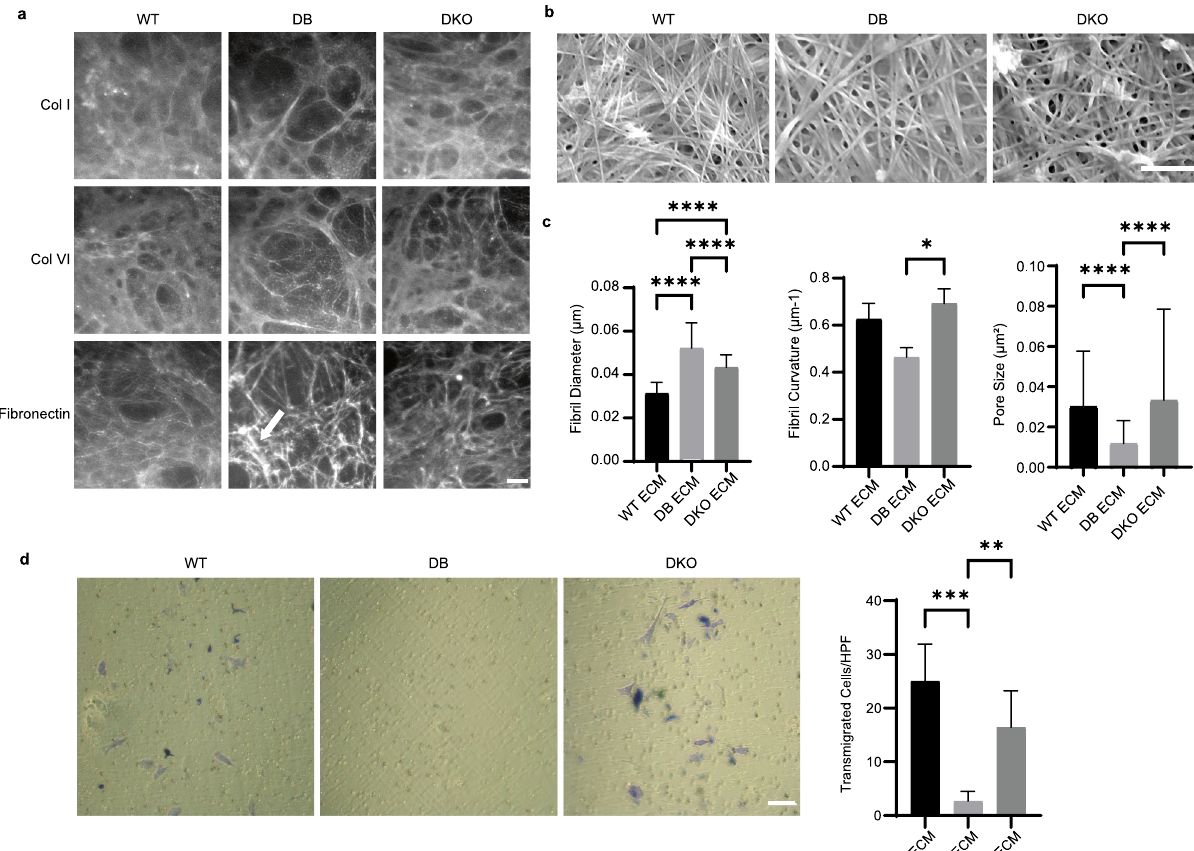
Figure 2. Cell-derived ECM from diabetic fibroblasts have thickened fibrils and lower porosity that hinder fibroblast transmigration. ( a ) IF images of ECM derived from WT, DB, and DKO fibroblasts show ECM proteins (collagen type I, collagen type VI, and fibronectin) organization. Arrow highlights the fibronectin-enriched matrix in ECM derived from diabetic fibroblasts. Scale bar is 40 μm. ( b ) Representative scanning electron images of ECM show thickened fibrils on a microscopic scale. Scale bar is 1 μm. ( c ) Left, measurements of fibril diameter show increased fibril size in diabetic ECM. Data were collected by averaging the diameter from 5 random locations along a fibril (n animals = 3 per group, n fibrils = 30 per animal). Middle, measurements of fibril curvature show increased curvature in DKO ECM compared to DB ECM (n animals = 3 per genotype, n fibrils = 60 per animal). Error bar refers to standard error of mean. Right, measurements of pore size show decreased size in DB ECM (n animals = 3 per genotype, n pores = 60 per animal). One-way ANOVA followed by Tukey’s post hoc test and multiple comparison test. ****p < 0.0001, *p < 0.05. ( d ) Left, representative images of the bottom fields of transwells after 8 h show fewer transmigrated cells in group with DB ECM. Cells were stained purple. Scale bar = 100 μm. Right, quantification of transmigrated cells after 8 h show fewer cells transmigrated through DB ECM compared to WT and DKO ECM. Data were collected by averaging cell numbers from 5 random fields per sample (n animals ≥ 4 per group). One-way ANOVA followed by Tukey’s post hoc test and multiple comparison test. ***p < 0.001, **p <